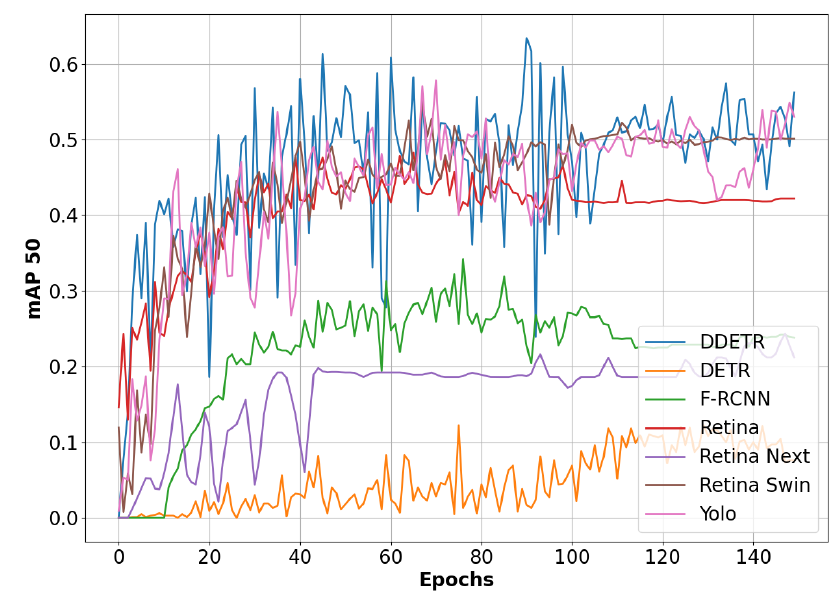
Figure 9. mAP 50, val development during training of the sheet metal use case.